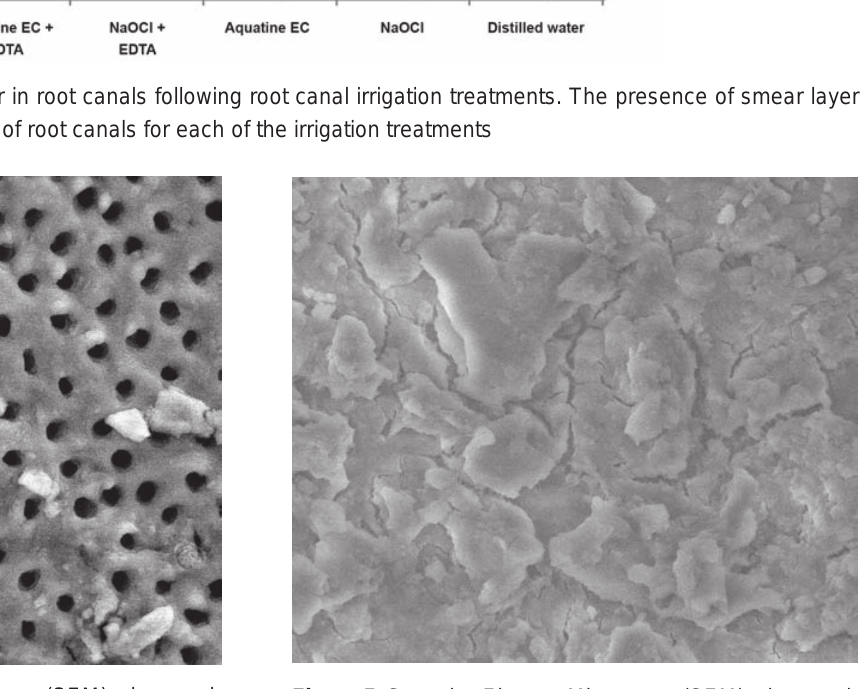
Figure 5- Scanning Electron Microscopy (SEM) micrograph of a root canal irrigated with Aquatine EC. No